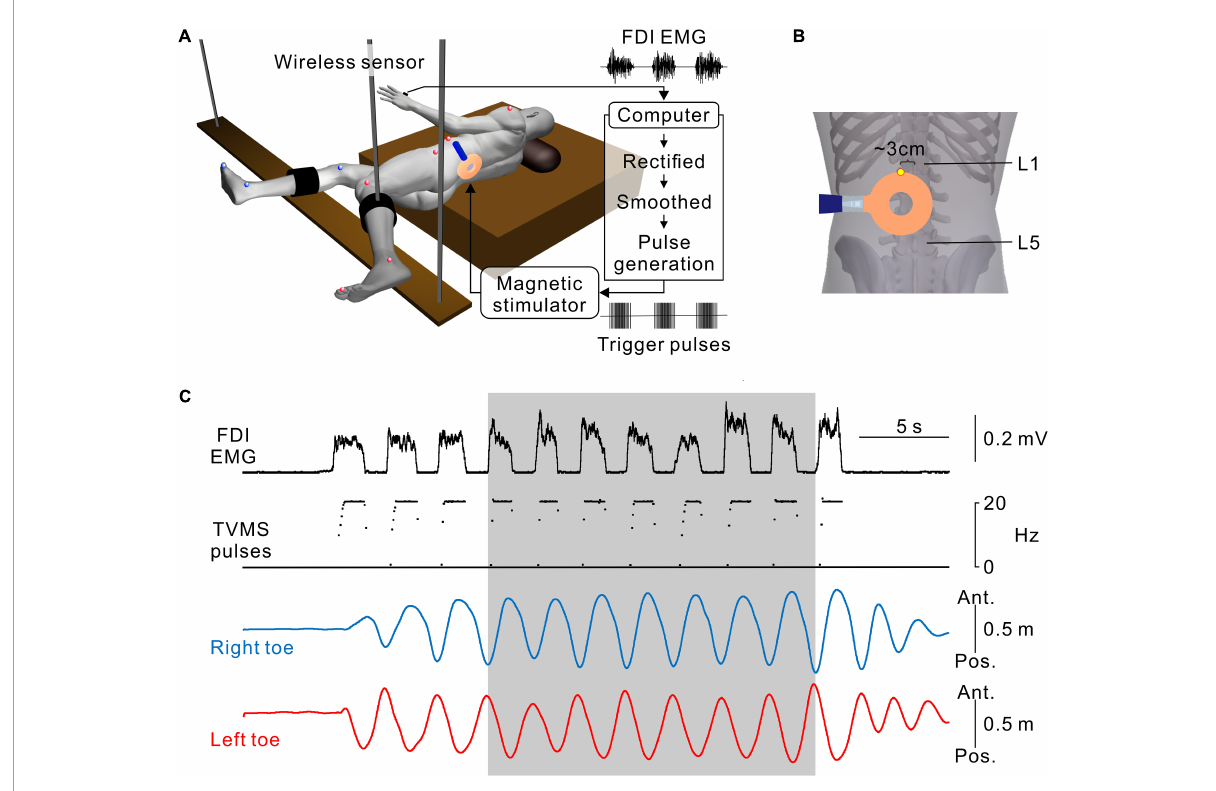
FIGURE1 Hand muscle-controlled transvertebral magnetic stimulation (TVMS) to induce leg movements. (A) Schematic illustration of the experimental setup and apparatus. The participant was in a semi-prone position on a bed with the left side up. The right and left legs were secured on leg braces that were suspended by wires from the ceiling. Reflective markers for a three-dimensional motion capture system were placed on the shoulder, 6th rib under the arm, iliac crest, major trochanter, knee, malleolus, and toe on the left (red spheres), and major trochanter, knee, malleolus, and toe on the right (blue spheres). Electromyography (EMG) recorded from the first dorsal interosseous muscle (FDI) was transformed to TVMS pulses via a closed-loop algorithm. (B) An example of stimulus coil configuration. The upper edge of the round coil was set at an intervertebral space between L1 and L2 (yellow dot). (C) An example of walking-like movements evoked by TVMS at an intensity of 70% maximum stimulator output (MSO). According to the amplitude of the FDI EMG (1st row), the temporal profile of TVMS (2nd row) was controlled by the participant. Right and left toe movements (3rd and 4th rows) are presented on the antero-posterior axis. Seven continuous cycles of movements, in which the amplitude and cycle of leg movements became stable at least after the 3rd cycle from initiation, were used for further analysis (gray